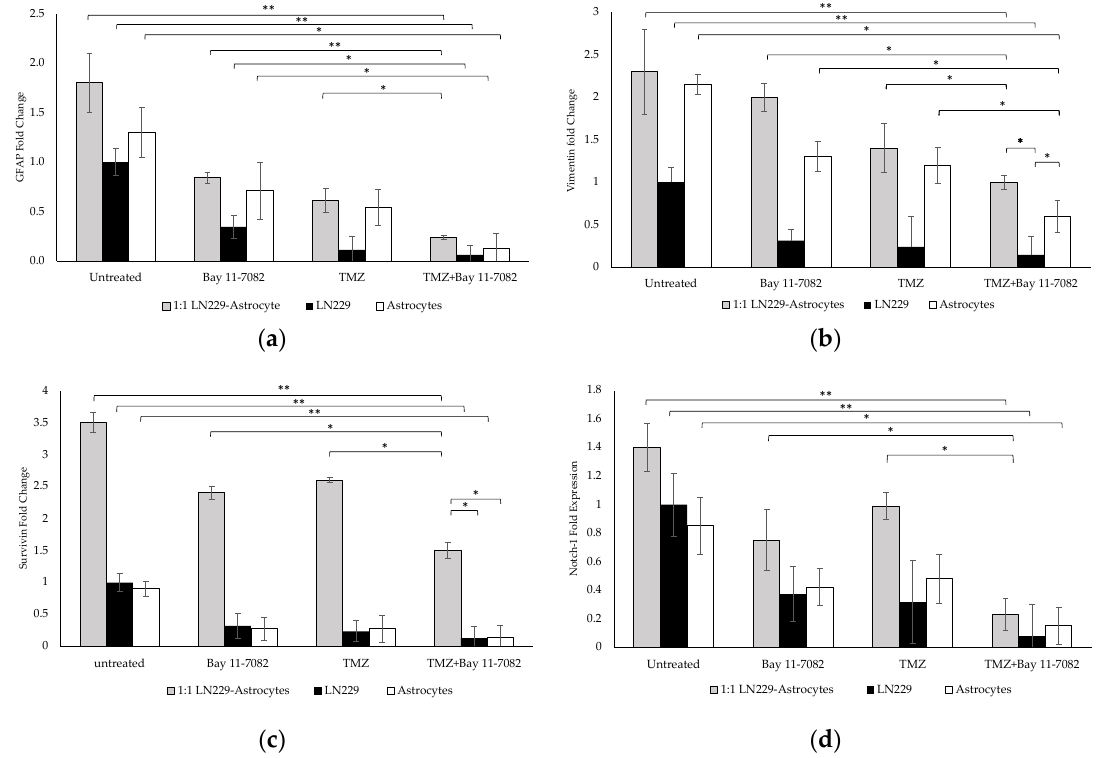
Figure 4. Gene expression analysis. Fold changes of ( a ) glial fibrillary acidic protein (GFAP), ( b ) vimentin, ( c ) Notch ‐ 1, and ( d ) survivin genes in the co ‐ culture and mono ‐ cultures. LN229 cells and astrocytes were treated with or without drugs for 7 days. Results were normalized to GAPDH total RNA level. Data represent the mean ± SD of three biological replicates. * indicates p < 0.05, ** indicates p < 0.01.